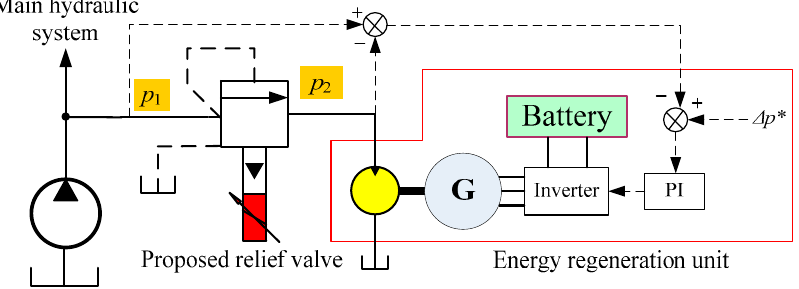
Figure 12. Control framework of energy regeneration system for the relief valve.